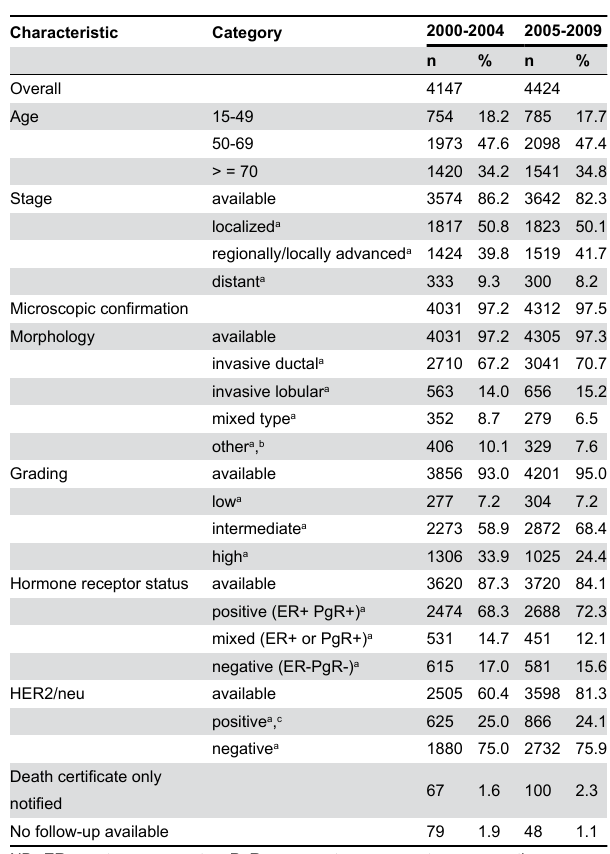
Table 1. Characteristics of patients with invasive breast cancer (ICD-10: C50) diagnosed in Saarland in 2000-2009.